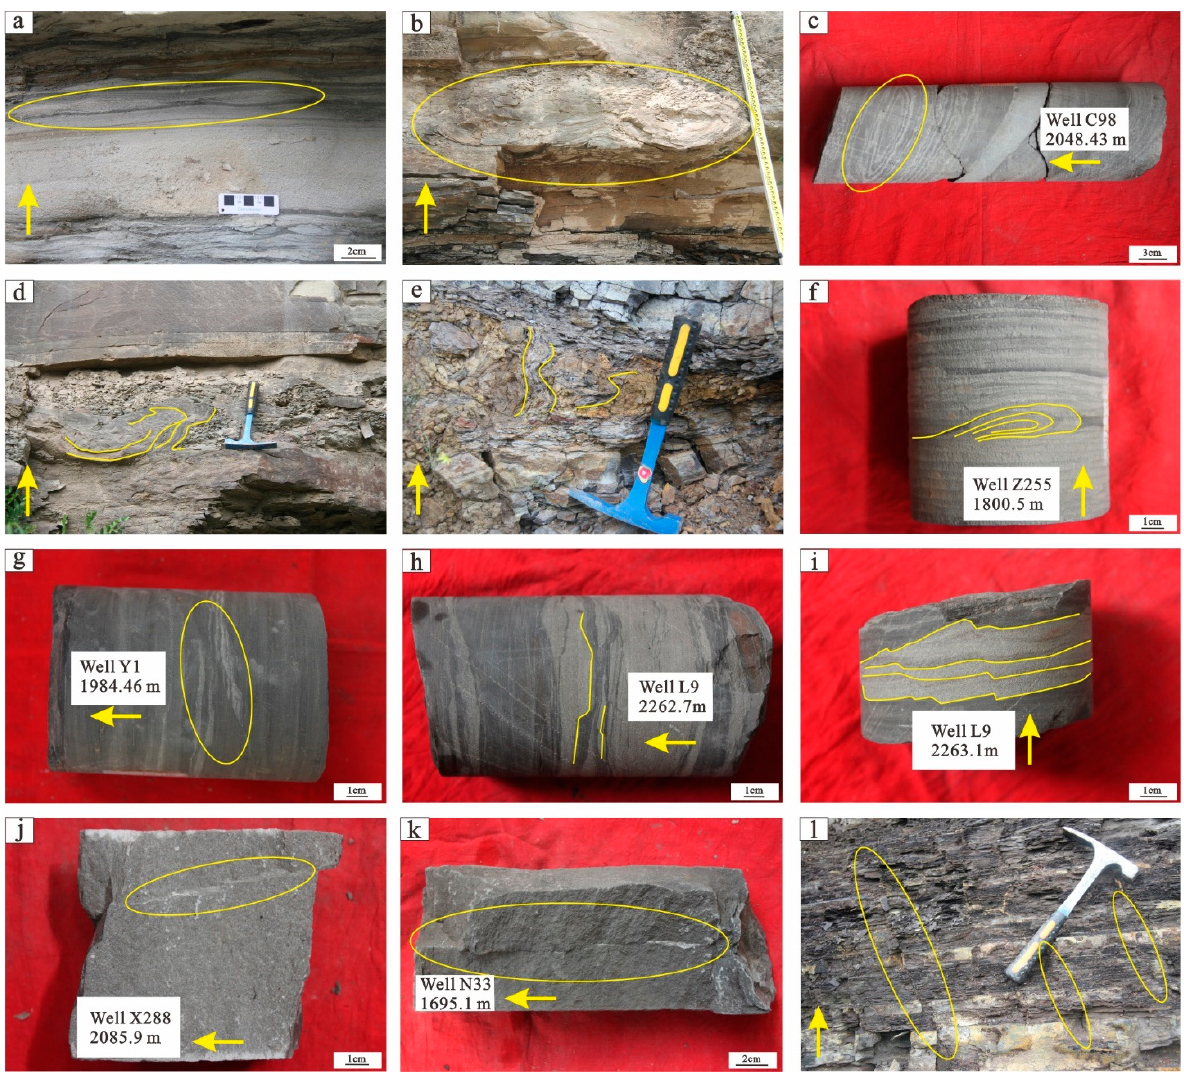
Figure 3. Soft-sedimentary deformation structures ( a ): Yaoqu-2, Chang-7 Member, loop bedding;